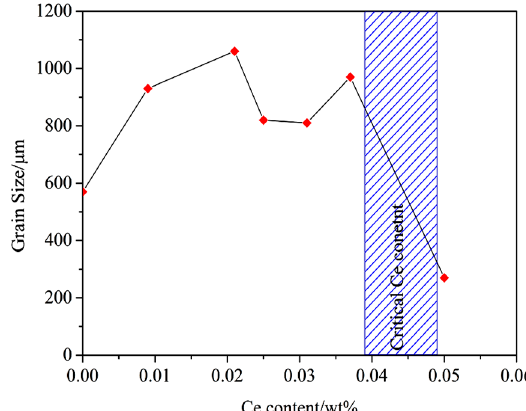
Figure 2. Relationship between the grain size and cerium content in a cast high manganese austenitic steel, reproduced from Reference [43], with permission of AIS Tech, 2011.